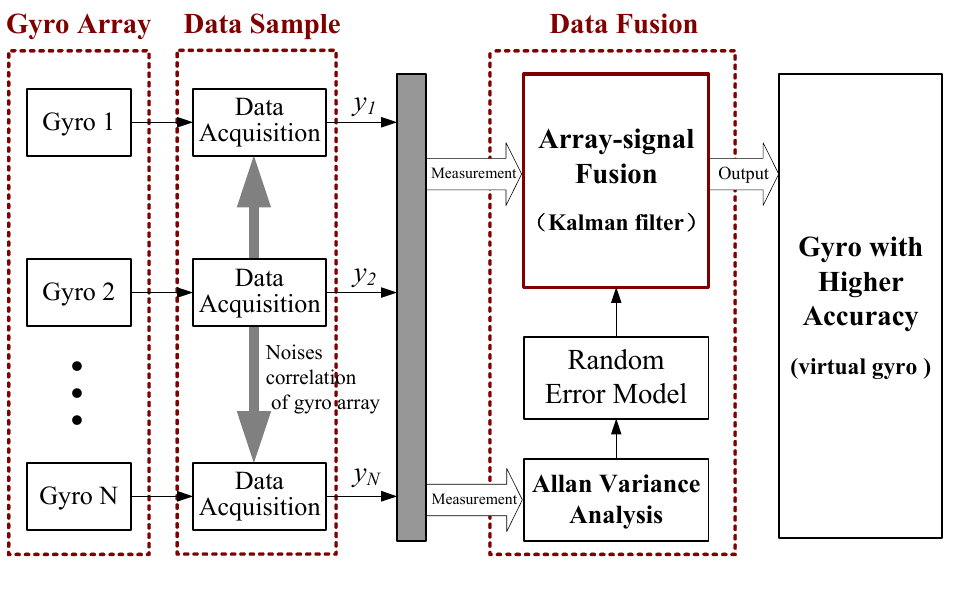
Figure 1. Structure and principle of the virtual